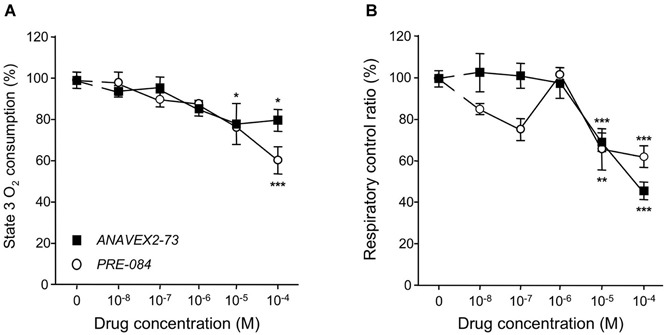
Direct application of ANAVEX2-73 or PRE-084 affected mitochondrial respiration only at high concentrations. Mitochondria (0.8 mg/ml) were loaded in the chamber with appropriate buffer at 30°C. The drugs (10−8 to 10−4 M) were bath applied 5 min before the repspiration measures. State 2 respiration was activated by addition of pyruvate-malate (5 mM). State 3 respiration was induced with ADP. State 4 respiration was provoked by the addition of carboxyatractyloside (CAT), a blocker of ATP-ADP carrier. The respiratory control ratio is the state 3/state 4 ratio. n = 4–8 per group (n = 14 for the no-drug group), F(5,38) = 3.08, p < 0.05 for ANAVEX2-73 and F(5,31) = 5.19, p < 0.01 for PRE-084 in (A); F(5,38) = 22.1, p < 0.0001 for ANAVEX2-73 and F(5,31)= 7.53, p < 0.001 for PRE-084 in (B). *p < 0.05, **p < 0.01, ***p < 0.001 vs. no-drug data; Dunnett’s test.